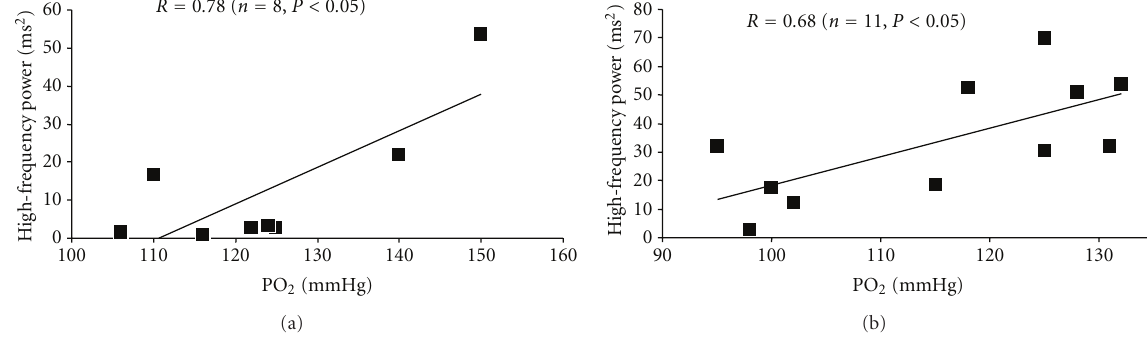
Figure 2: Relationship between partial pressure of oxygen (PO 2 ) and high-frequency power (HF) at 4min 400 m (a) and 300m (b) postexercise